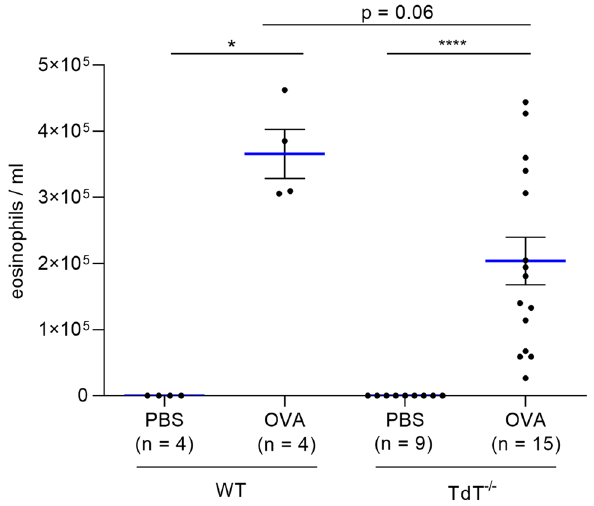
Figure 3. Content of eosinophils in bronchoalveolar lavage (BAL) fluids. In BAL fluids of wt and TdT −/− mice, both sensitized and non-sensitized, content of eosinophils were measured using a pulse area counter. No eosinophils were detectable in the BAL fluids of non-sensitized animals. This applies to both genotypes, wt and TdT −/− . Sensitization and aerosolic challenge with OVA caused a significant influx of eosinophils ( wt p < 0.001 and TdT −/− p < 0.0001) in both genotypes. However, this influx was markly reduced in TdT −/− mice compared to wt mice (p = 0.06; mean shown as blue lines, SEM shown as black bars).